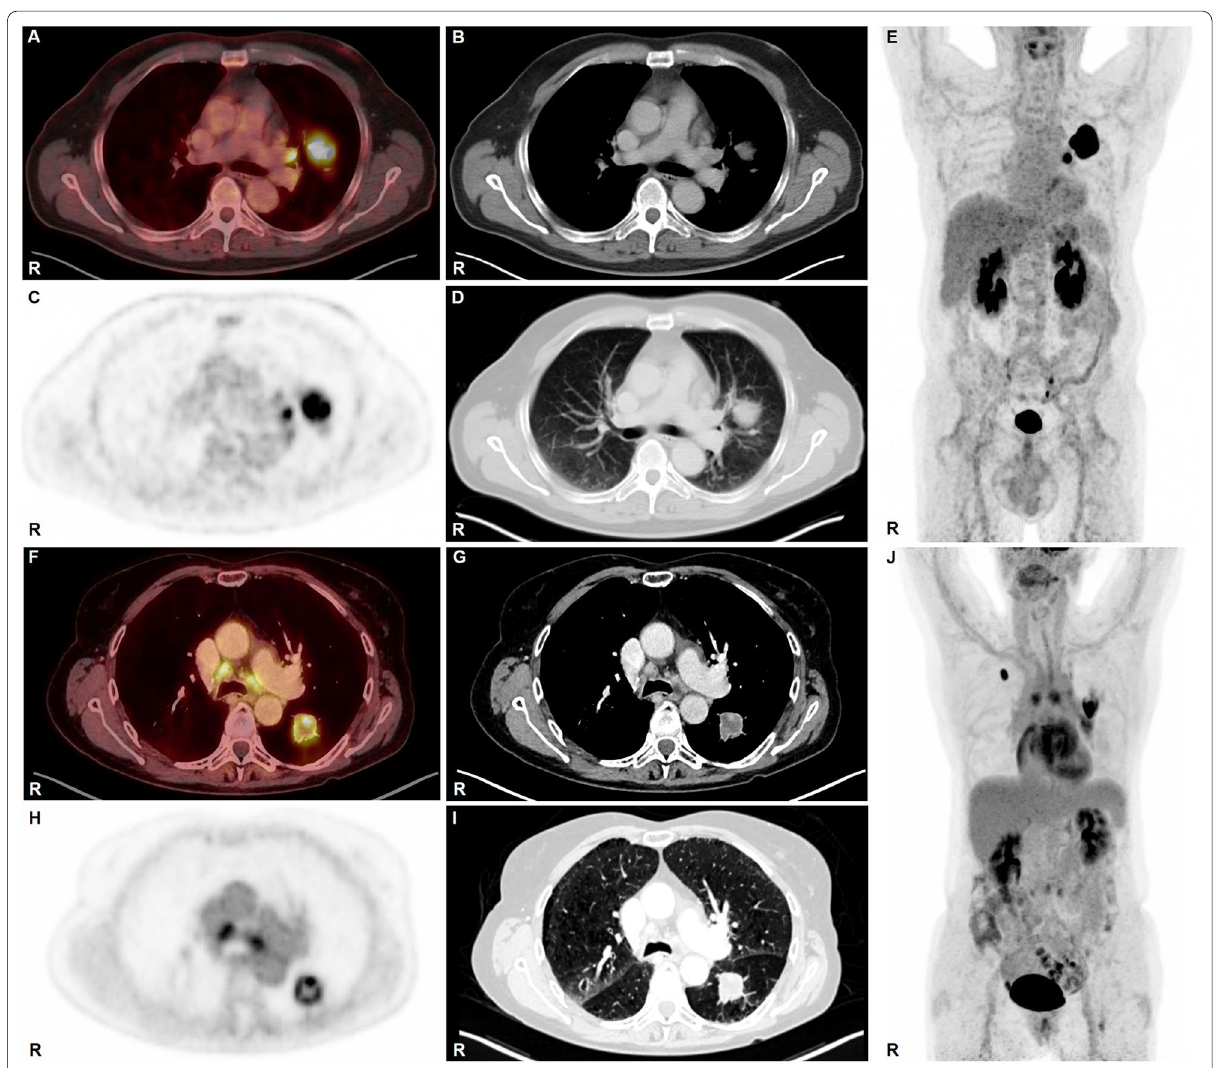
Fig. 3 A – E true positive lymph node: [ 18 F]FDG PET/CT: male, age 58 years, LCNEC pT3 pN1 (1/11) M0, stage IIIa. SUV max primary 17.7, SUV max true positive lymph node metastasis 10.8. A [ 18 F]FDG PET/CT fusion, B CT chest soft tissue window, C PET attenuation-corrected emission, D CT chest lung window, E PET maximum intensity projection (MIP). F – J false positive lymph node: [ 18 F]FDG PET/CT: female, age 66 years, LCNEC pT1c pN0 (0/21) pM1a (resected single metastasis in contralateral lung), stage IVa. Patient underwent EBUS-TBNA 3 days prior to FDG PET/CT. SUV max primary 15.8,